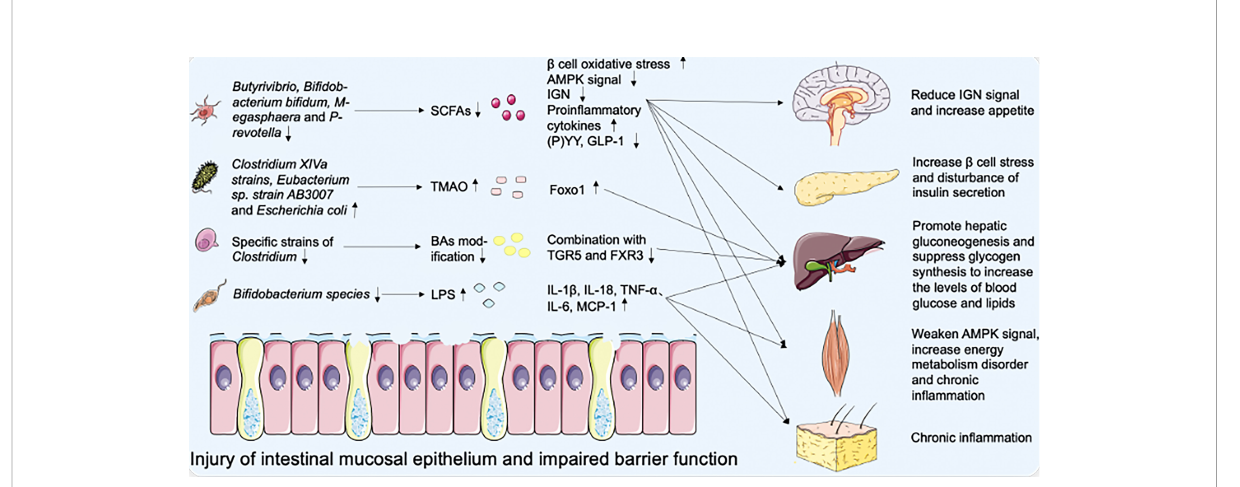
FIGURE 1 Effect of intestinal microbiota disorder on metabolic dysfunction of multiple